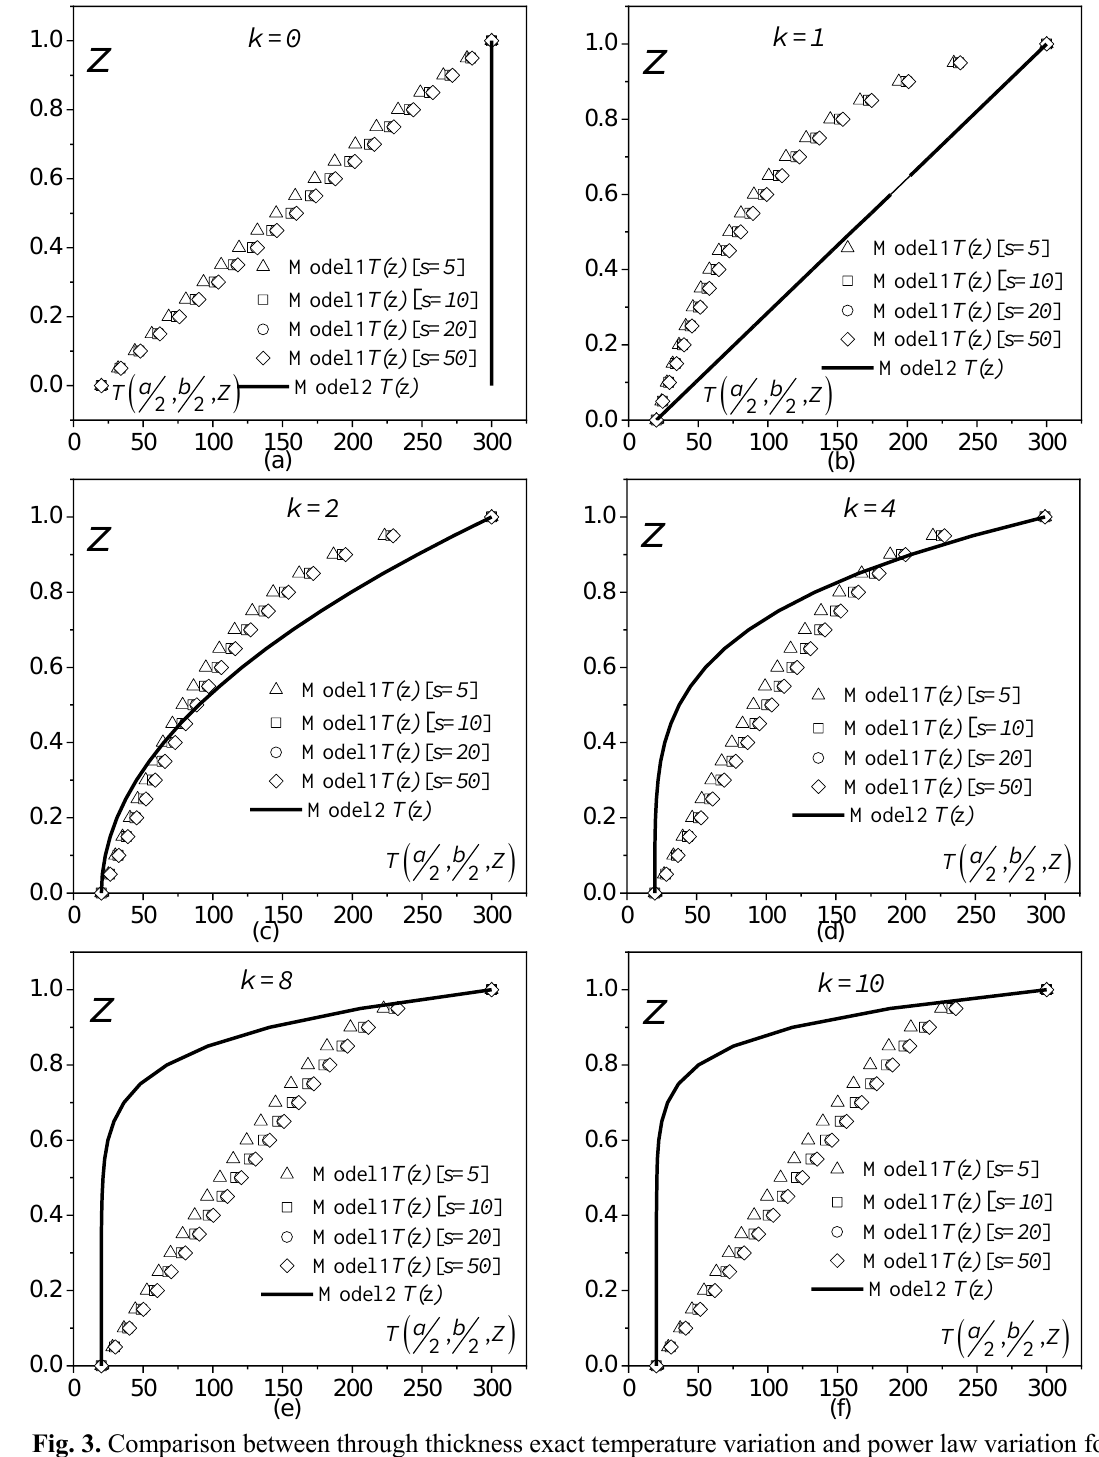
Fig. 3. Comparison between through thickness exact temperature variation and power law variation for different power index ( k) for square laminate material set